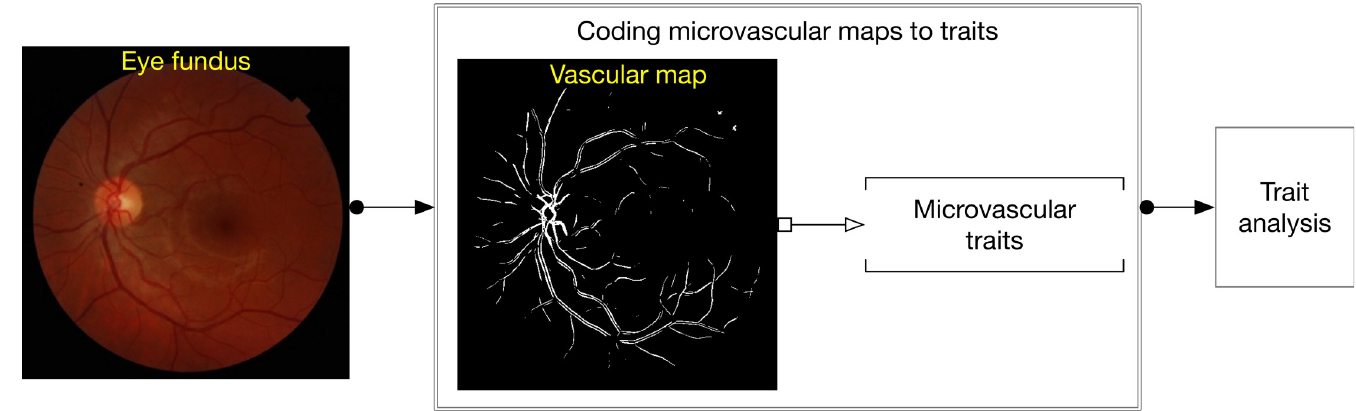
Fig 1. Schematic diagram for analyzing vascular